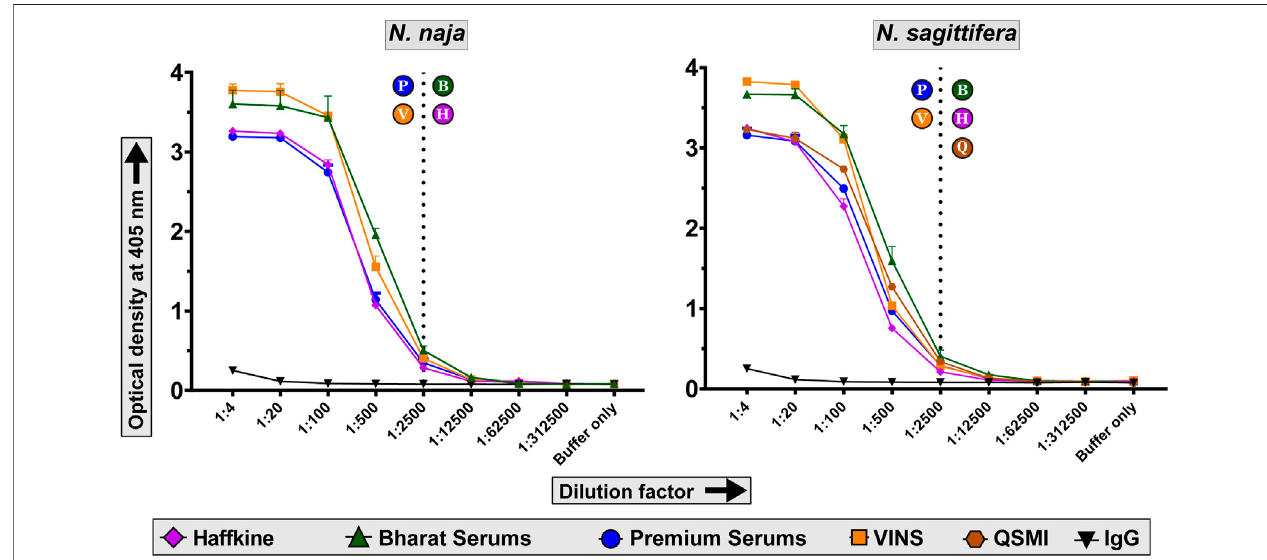
FIGURE 5 | Venom recognition capabilities of commercial antivenoms. The line graphs in this fi gure indicate the in vitro venom binding of naive horse IgG and commercial Indian polyvalent and Thai monovalent antivenoms against N. naja and N. sagittifera . Multiple dilutions of antivenoms were evaluated in these indirect ELISA experiments. Dotted lines indicate the titre value of antivenoms against the two venoms. The alphabets in circles next to the dotted lines indicate the respective titres of antivenoms: P — Premium Serums and Vaccines Pvt. Ltd.; V — VINS Bioproducts Ltd.; B — Bharat Serums and Vaccines Ltd.; H — Haffkine Bio-Pharmaceutical Corporation Ltd. and Q — Queen Saovabha Memorial Institute monovalent N . kaouthia antivenom.